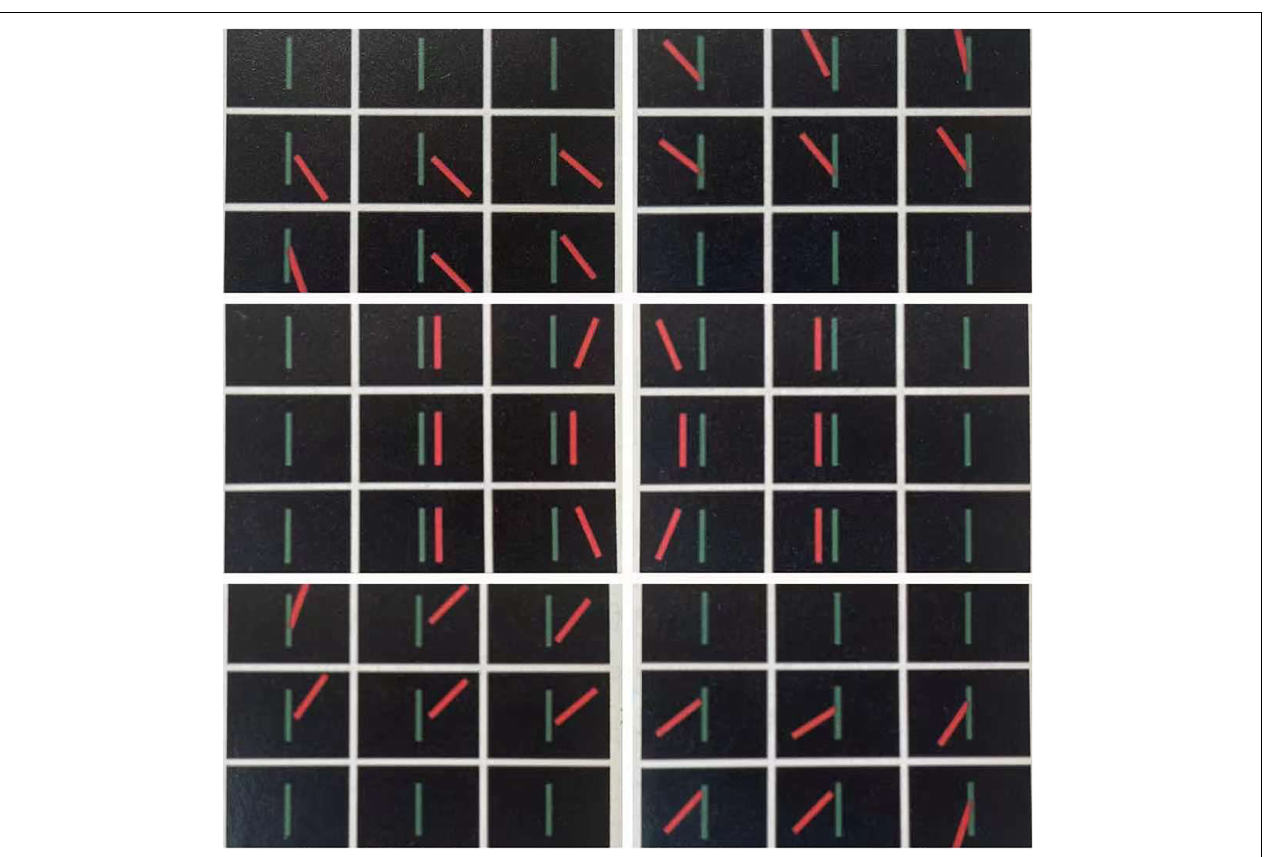
FIGURE 1 | Diplopia in each of the external ocular muscles with